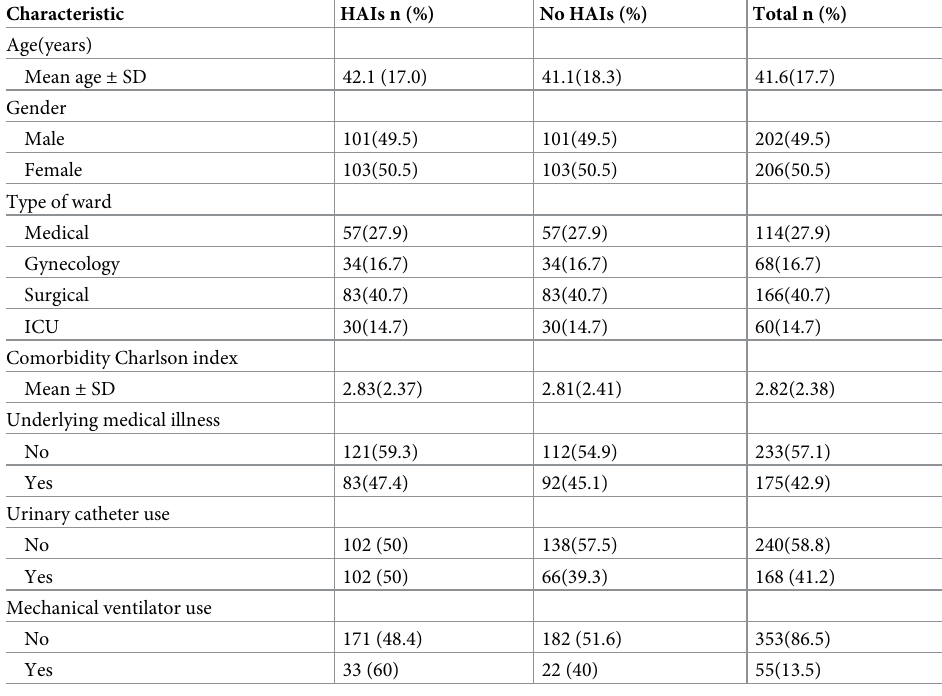
Table 1. Demographic and clinical characteristics of patients with and patients without healthcare-associated infections at ACSH, Nov. 2019-Mar. 2020. Characteristic